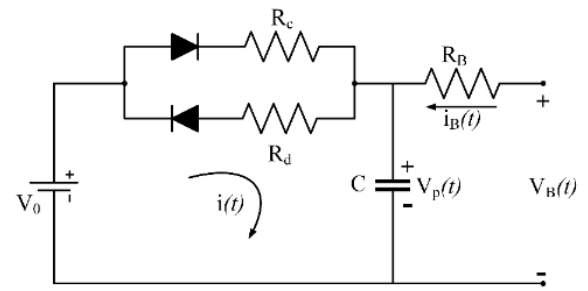
Figure 23. Equivalent circuit of a rechargeable lead-acid battery based on the nonlinear Thevenin model [76].